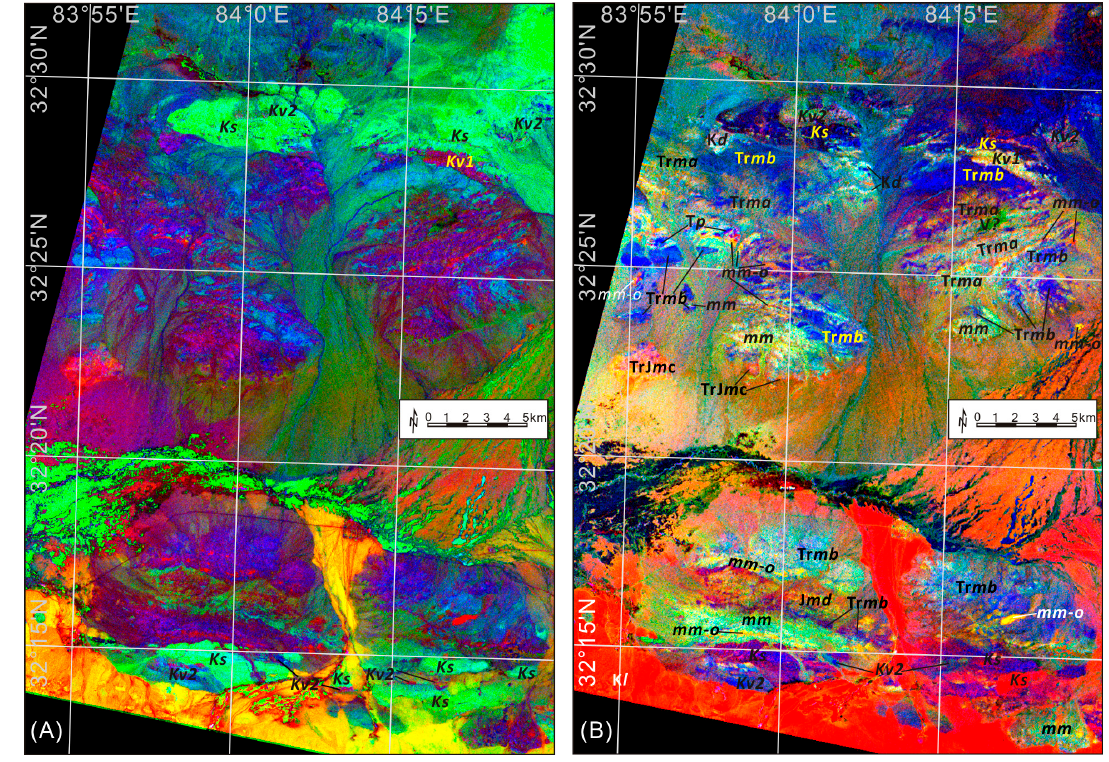
Figure 12. FCC images of the VNIR-SWIR band ratios. ( A ) Red— (band 6 + band 9)/band 8 , Green— band 2/band 1 , Blue— (band 5 + band 7)/band 6 ; ( B ) Red— (band 6 + band 9)/band 8 , Green— (band 1/band 2 + band 5/band 4) , Blue— (band 5 + band 7)/band 6 . See text and Figure 8 for interpretation of the labels of lithologic